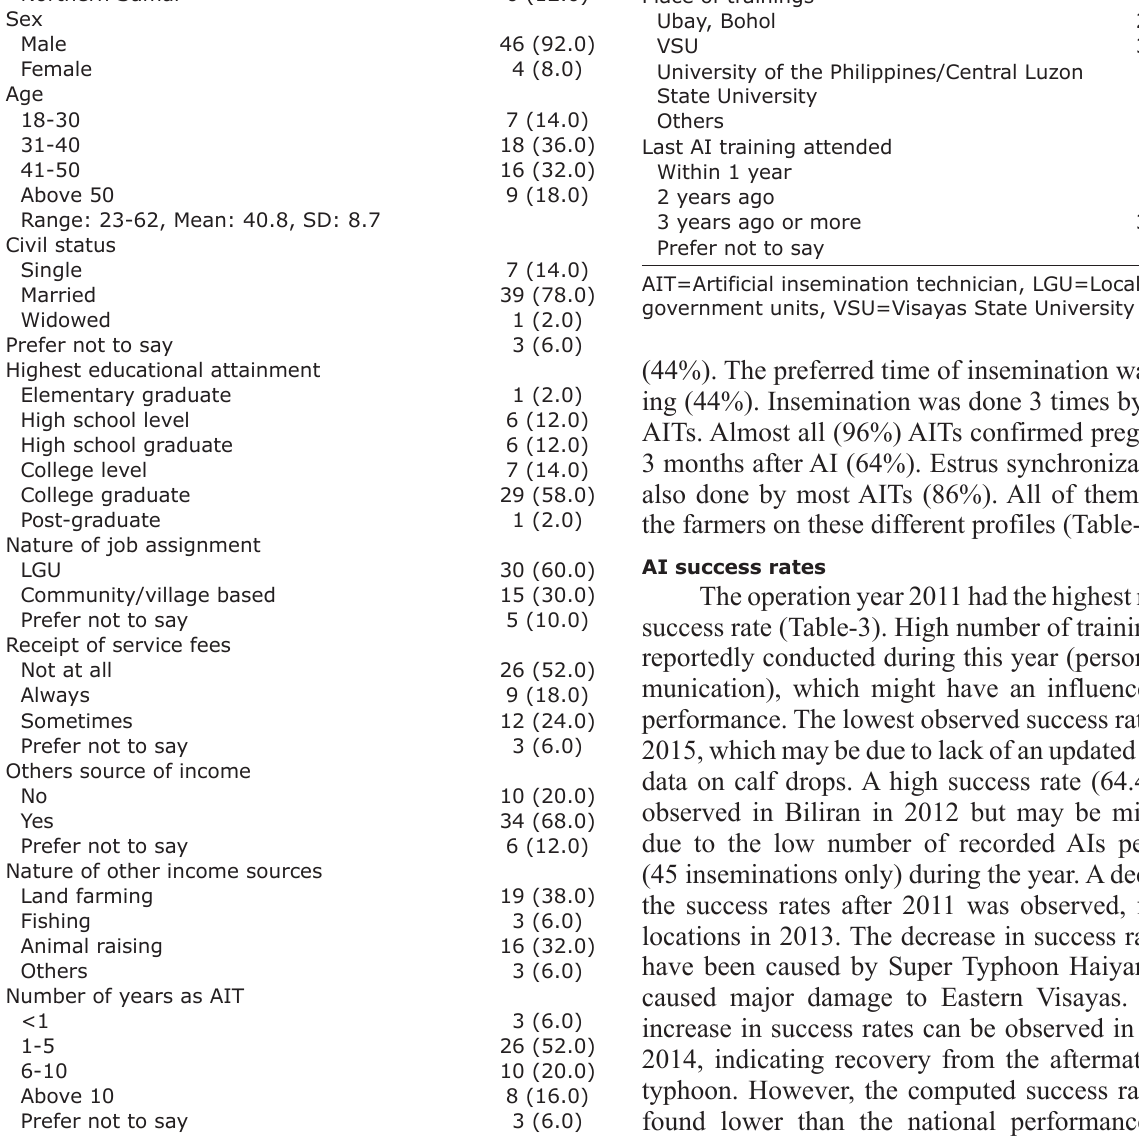
Range: 23-62, Mean: 40.8, SD: 8.7